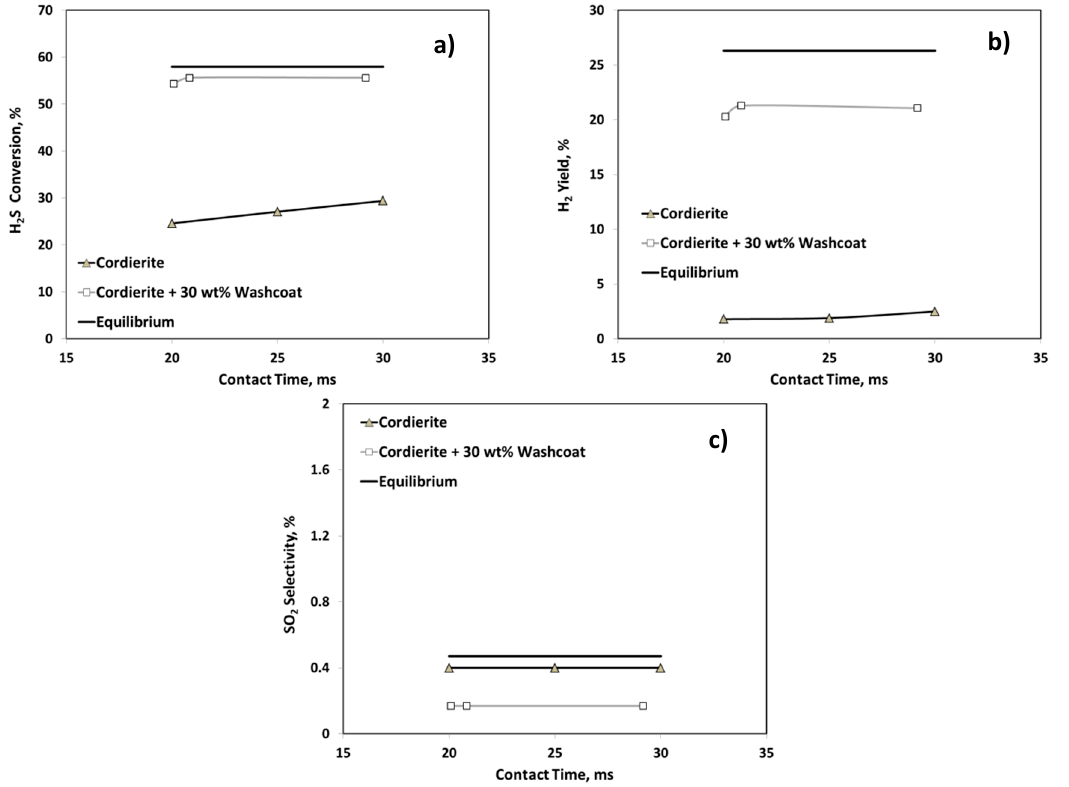
Figure 4. Catalytic performance of cordierite, washcoat + cordierite in terms of H 2 S conversion ( a ), H 2 yield ( b ), SO 2 selectivity ( c ) (T = 1100 °C).